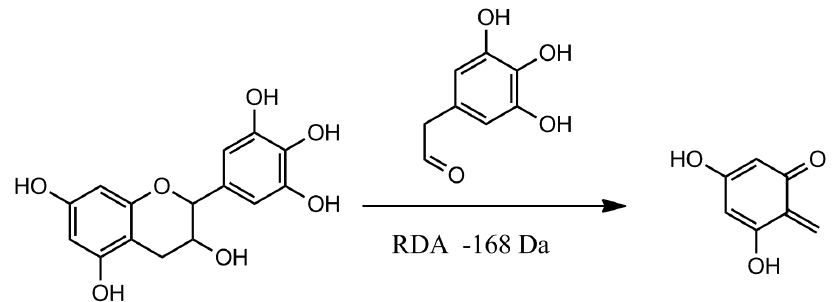
Figure 4. Retro-Diels–Alder (RDA) fragmentation pattern of gallocatechin.